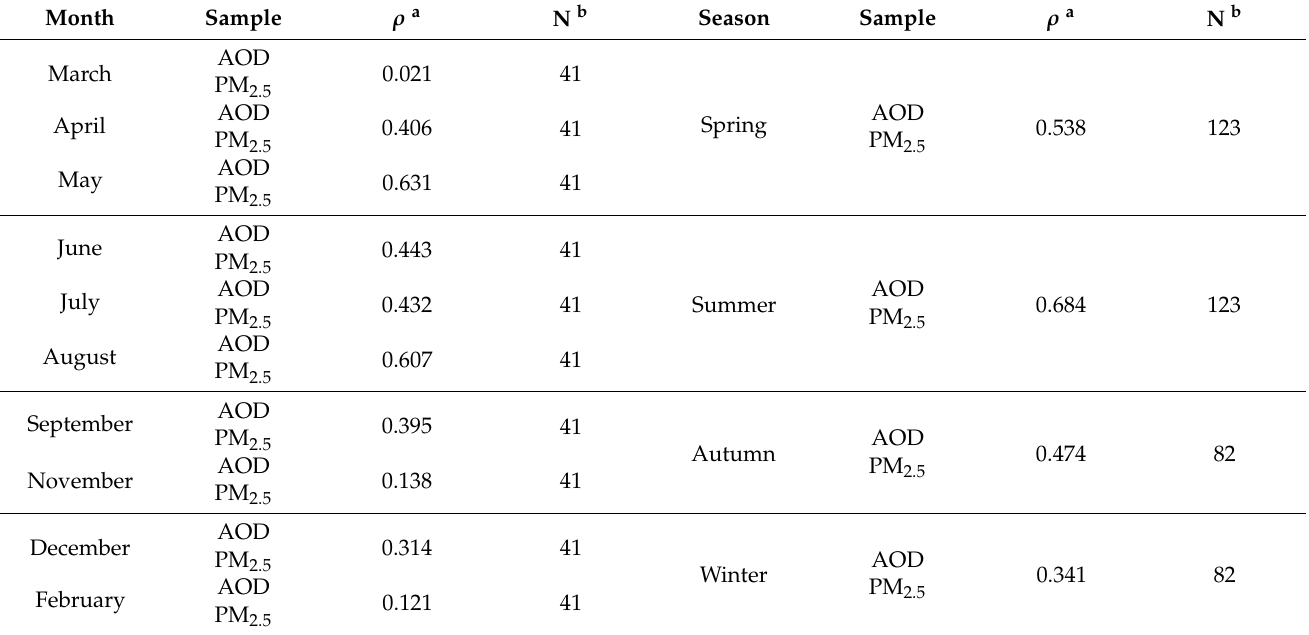
Table 6. Correlation analysis of inversion AOD and observation PM 2.5 (at 0.01 confidence